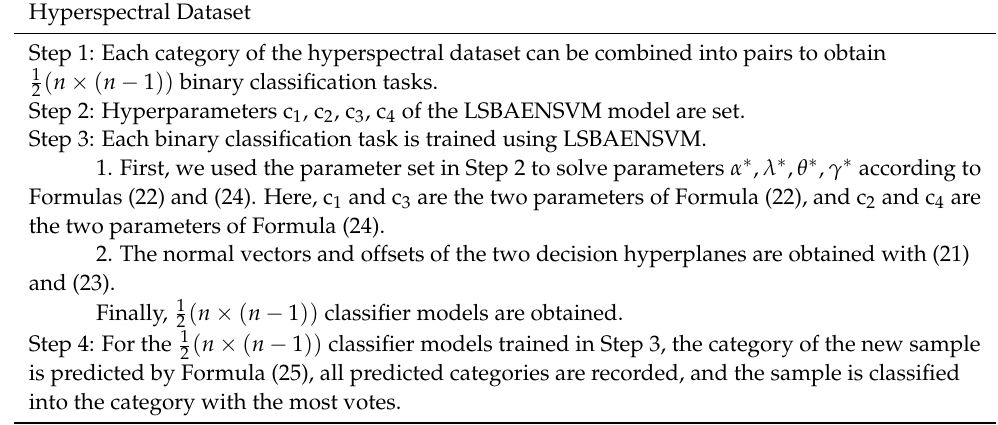
Algorithm 1: The Classification Process of the LSBAENSVM Algorithm Model for a Hyperspectral